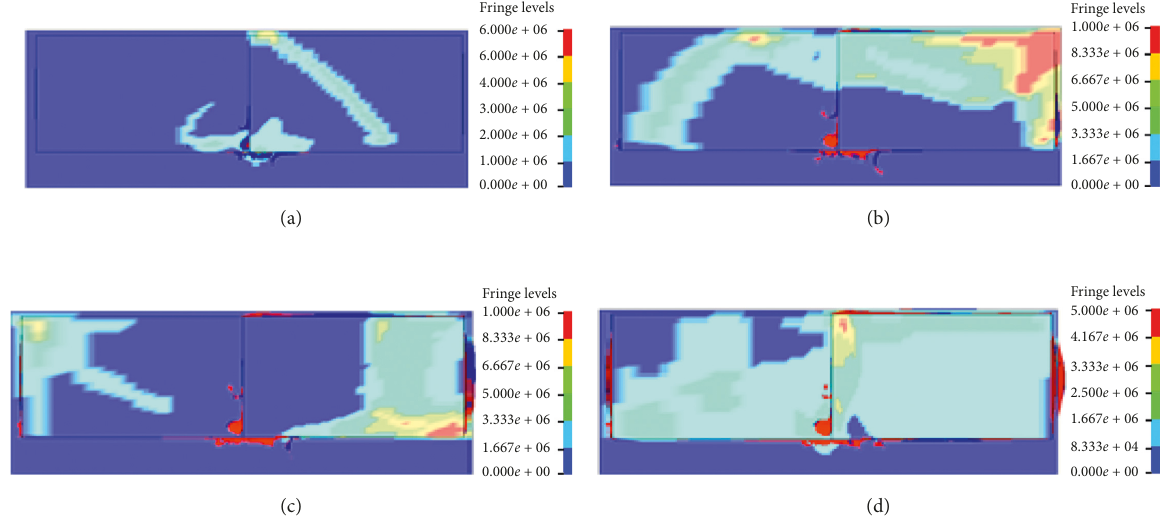
Figure 11: Response process of explosion in position 4 (the axial longitudinal section, time unit: ms). (a) t (c) t 5.1991. (d) t 9.7986. (cid:30) (cid:30)